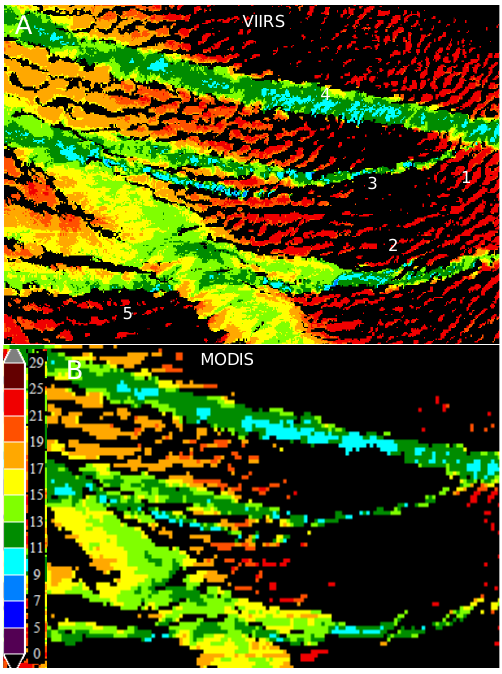
Fig. 2. VIIRS and MODIS retrieved r e for the clouds shown in Fig. 1. Only clouds with 0.6µm solar reflectance >0.3 are